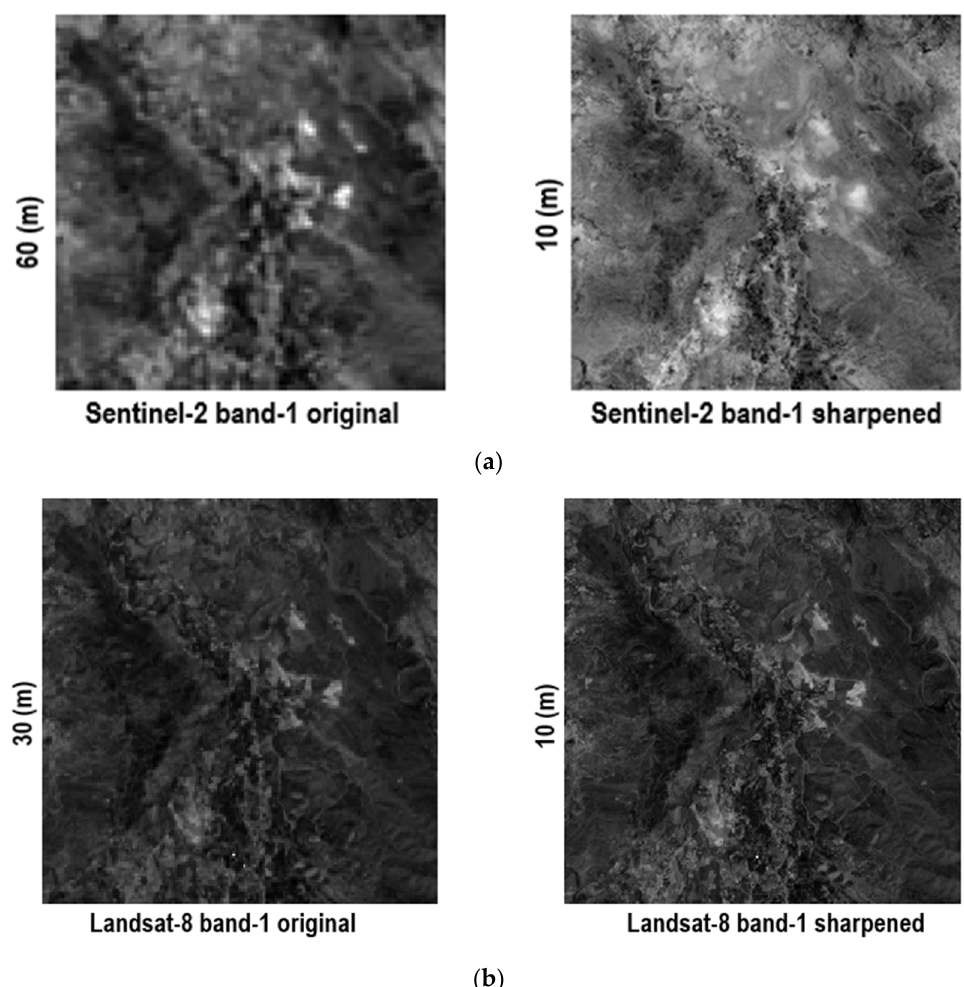
Figure 8. ( a ) Left : Sentinel-2 band 1 original, Right : Sentinel-2 band-1 sharpened image. ( b ) Left : Landsat 8 band-1 original, Right : Landsat 8 band-1 sharpened image. Table 4. ERGAS, RMSE and SAM scores. Table 5. SRE, SSIM and UIQI